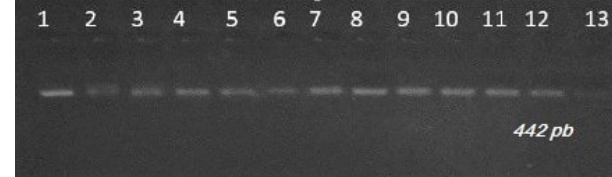
Figure 1. Gel electrophoresis of PCR products of leptin gene in Tunisian cattle. Lane 13: marker molecular weight; 100bp DNA ladder (Biomatik).